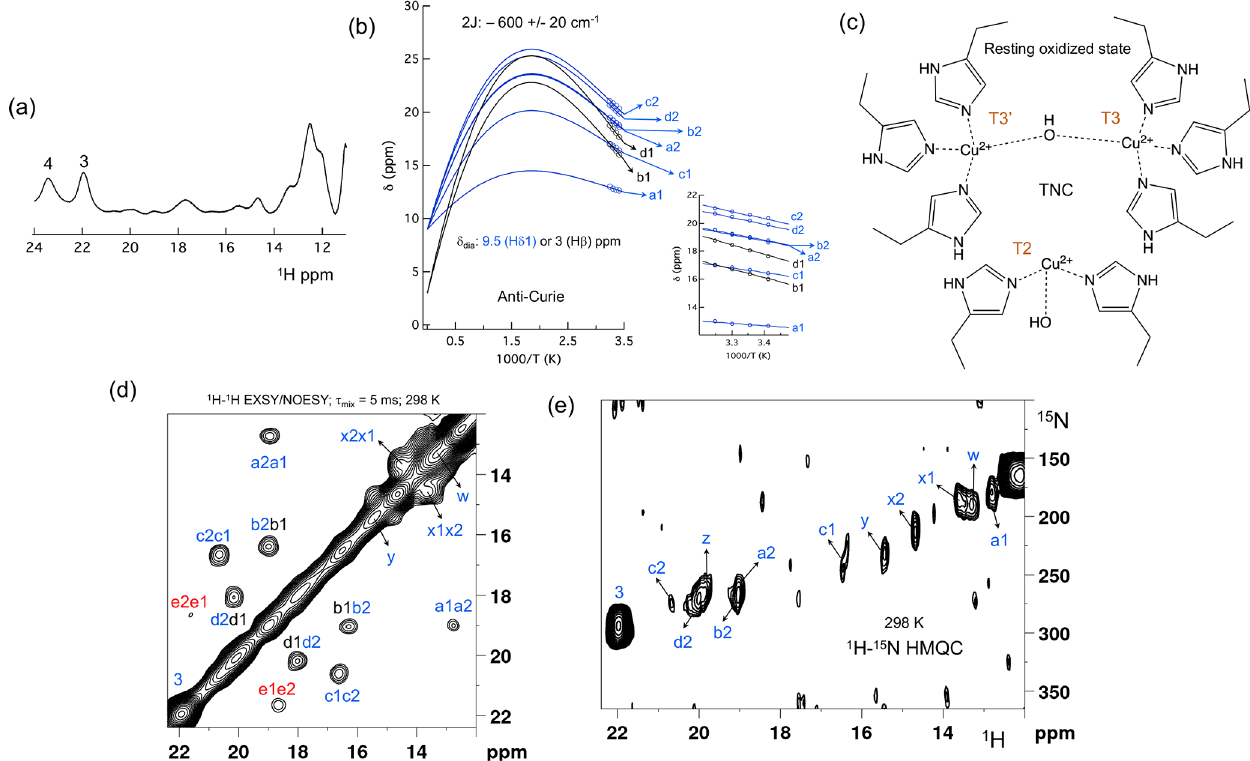
Figure 2. The spectral region of the RO state. (a) 1D 1 H spectra of the RO region from Fig. 1a. Resonances 3 and 4 of the NI state are shown for comparison; (b) temperature dependence of the chemical shift for resonances a1, a2, b1, b2, c1, c2, d1 and d2, fitted to the two-metal centre model (Eq. S1). The inset shows the experimental region of the fit. The corresponding hyperfine coupling constants are given in Table S5 of the Supplement; (c) schematic representation of the RO state of the TNC. The T3 and T2 copper ions are marked. (d) 1 H– 1 H EXSY/NOESY spectra of SLAC-T1D for the region between 12 and 22ppm; (e) 15 N- 1 H HMQC spectra of the 15 N uniformly labelled SLAC-T1D (12 to 22ppm in the 1 H dimension). The resonances marked in blue are for the nitrogen-attached protons, while resonances in black are for carbon-attached protons. Resonances in red in panel (d) could not be assigned to either nitrogen-linked or carbon-linked protons due to a low S/N